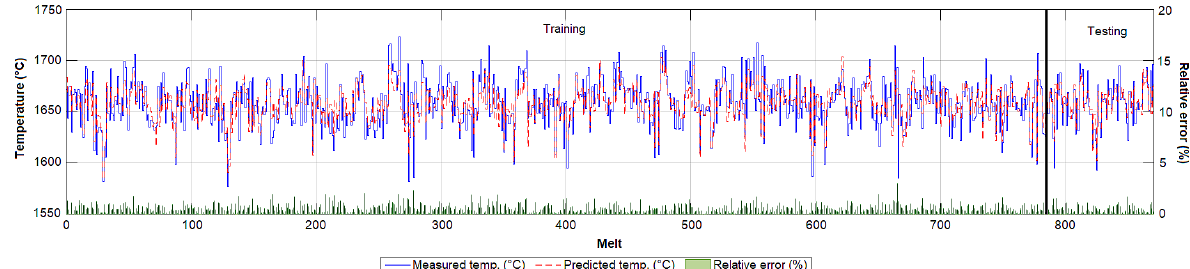
Figure 9. Prediction of endpoint melt temperature by piecewise-cubic MARS